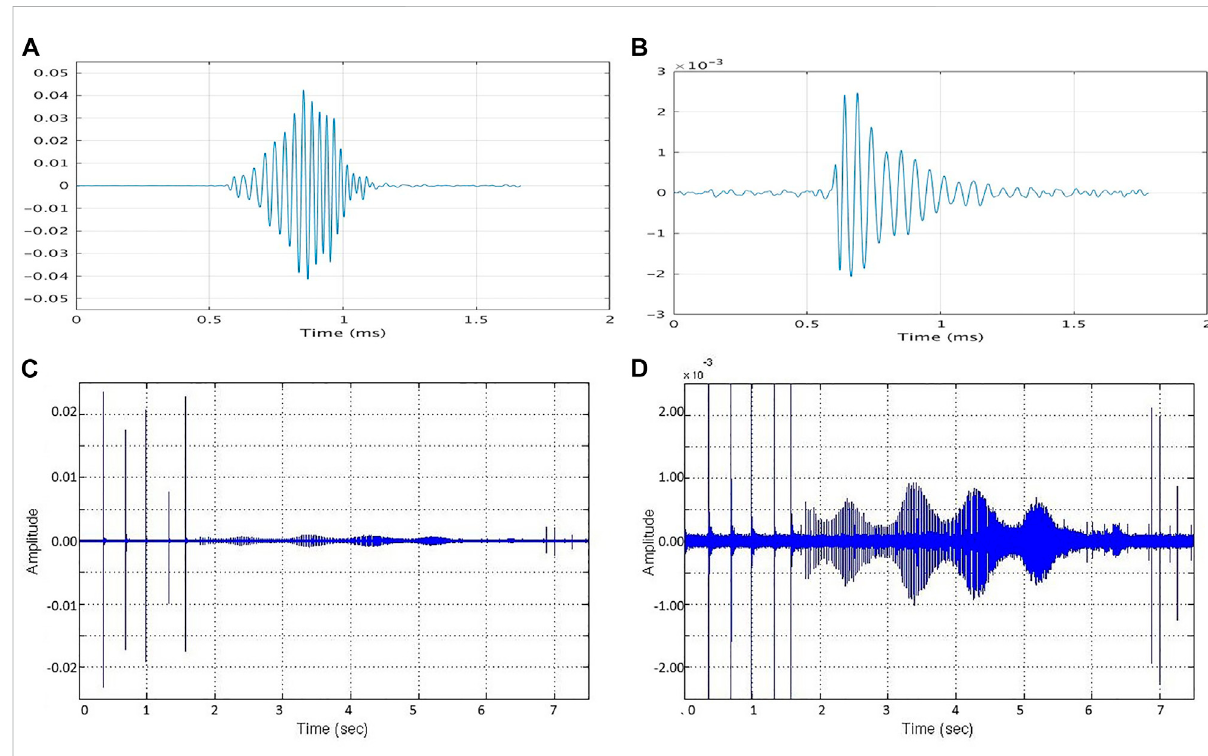
FIGURE 1 (A) A Md foraging click and (B) a Md buzz click as received by a bottom-mounted hydrophone at AUTEC. (C,D) A Md foraging click train transitioning to a buzz also received on bottom mounted hydrophone at AUTEC. Changes in amplitude during foraging and within the buzz and are due to relative orientation of the animal ’ s head to the hydrophone.